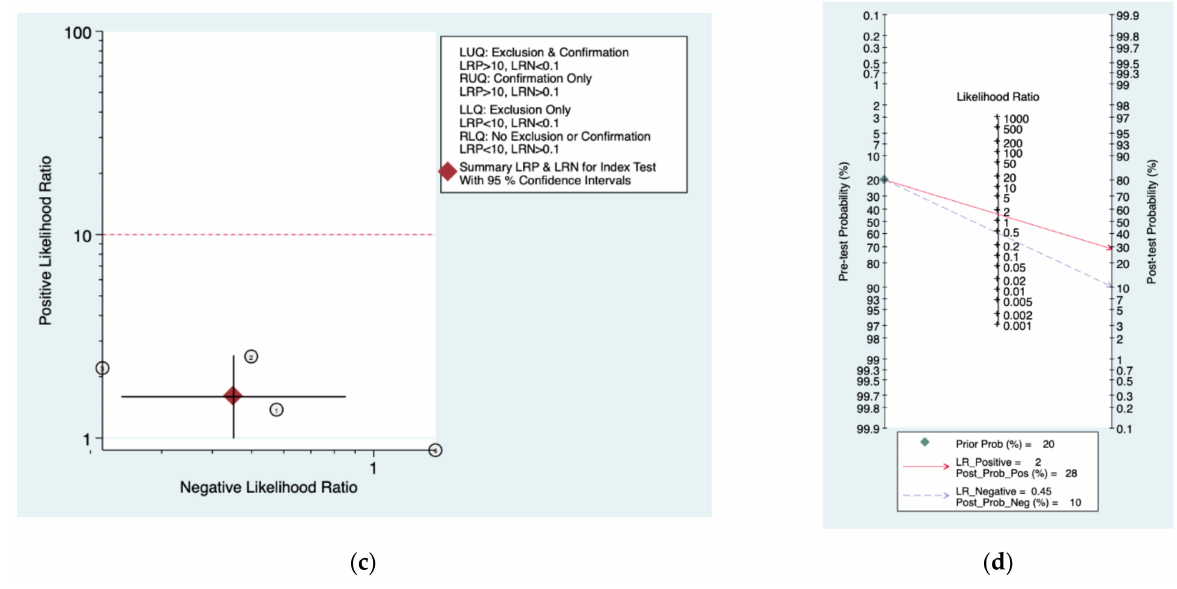
Figure 6. Meta‑analysis of Sheppard protocol. ( a ) Forrest plot of pooled sensitivity and